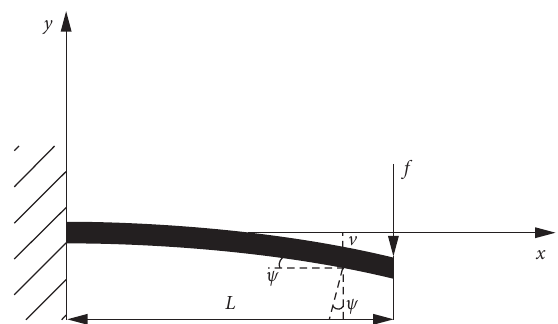
Figure 1: Structure of the composite boring bar with plane